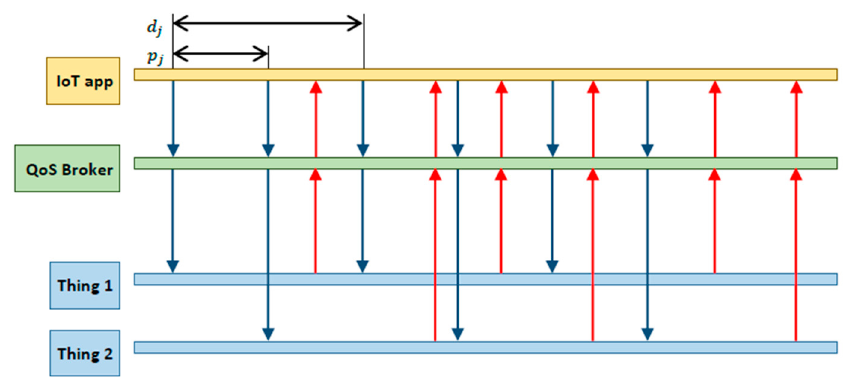
Figure 2. Periodic service invocations.